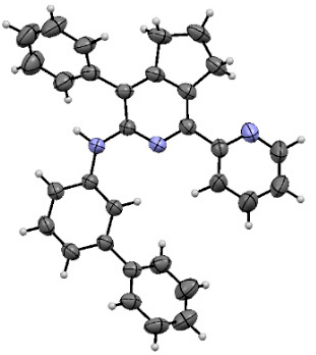
Figure 2. Structure of compound 3a based on X-ray diffraction data.